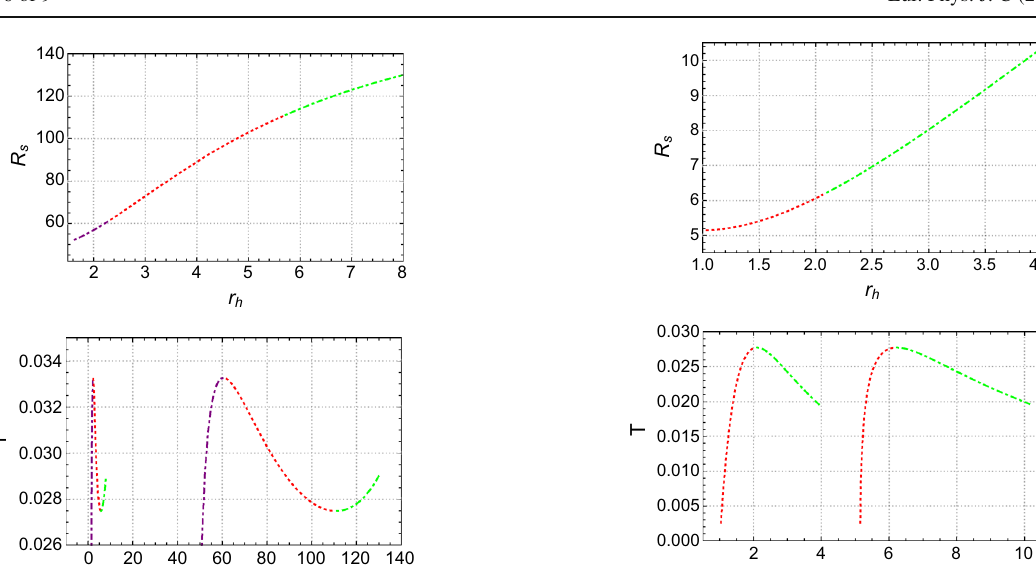
Fig. 4 The upper diagram shows the relation between the shadow radius and the event horizon for the Kerr black hole. The bottom dia- gram shows the temperature in terms of the event horizon (left curve) and the shadow radius (right curve) for the black hole, respectively. We set r O = 100 , J = 1 , θ O = π/ 2 , (cid:13) = 0. The red and green curves in the top diagram correspond to the curves with the same colours in the bottom diagram